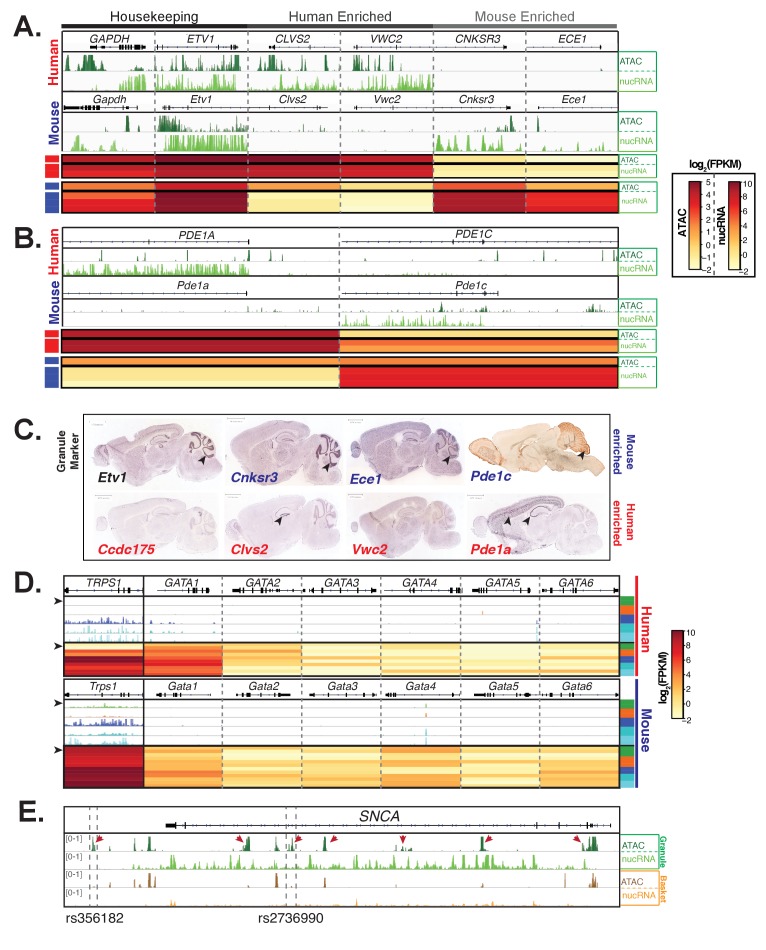
Relationship between chromatin accessibility and gene expression in cerebellar granule and basket neurons, related to Figure 4.(A) Stacked bar plot showing the proportion of peaks identified from ATAC-seq DNA accessibility assay from human and mouse cerebellar granule and basket neurons that map to various genomic regions. All: all peaks; DA: peaks that are differentially accessible between granule and basket neurons; n: total number of peaks for each category. Gene body contains peaks mapping to 5'UTR, exon, intron, 3'UTR, or TTS; Other contains peaks mapping to pseudogenes, miRNA, ncRNA, snoRNA, or rRNA. (B-C) Analysis of ATAC-seq DNA accessibility in for genes that are differentially expressed between granule and basket neurons. (B) Top: metagene analysis showing coverage in log2(FPKM) over the promoters of granule-enriched genes (1313 from mouse, 1100 from human) or basket-enriched genes (1124 from mouse, 1151 from human). Bottom: density plot showing enrichment of ATAC-seq reads over the promoters of each gene individually. (C) Same as (B) except coverage is shown over entire gene body. (D) Box plots showing normalized expression in granule (green) and basket (orange) neuron from human (left) and mouse (right), for genes associated with differentially accessible (DA) peaks between the two cell types. Expression is plotted separately for DA peaks located in promoter and transcription start site (TSS), 5' UTR, exon and intron, or 3' UTR and transcription terminal site (TTS) regions. T-test (two-sided, unequal variance) p-values comparing gene expression in granule cells versus basket cells are shown.